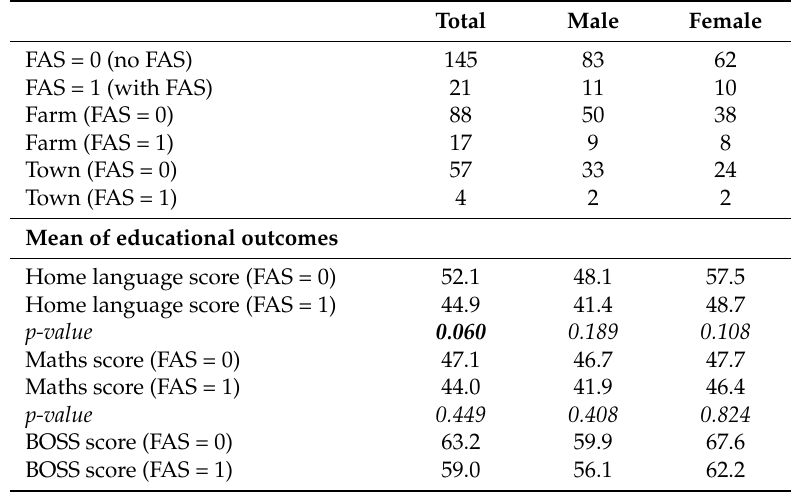
Table 1. Descriptive statistics of learners, Grades 1–4 in